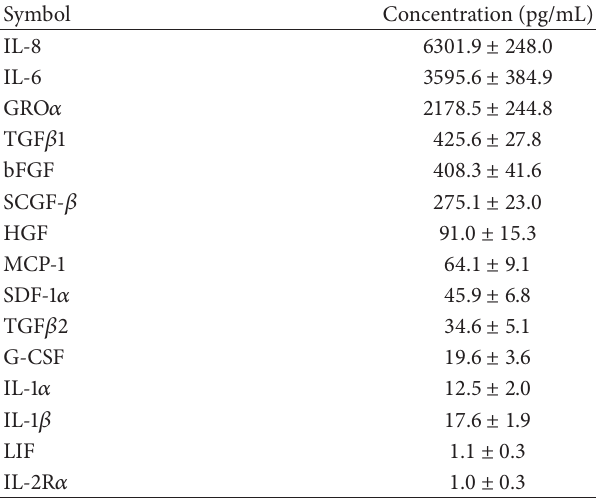
Table 1: 15 signal factors secreted by 2D-MSCs.